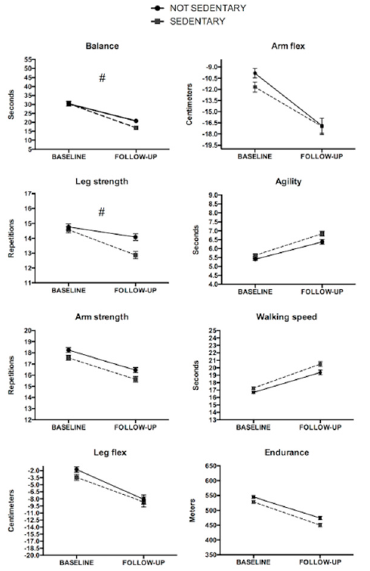
Figure 4. Fitness changes according to ST during the follow-up in females. # Significant group-by-time